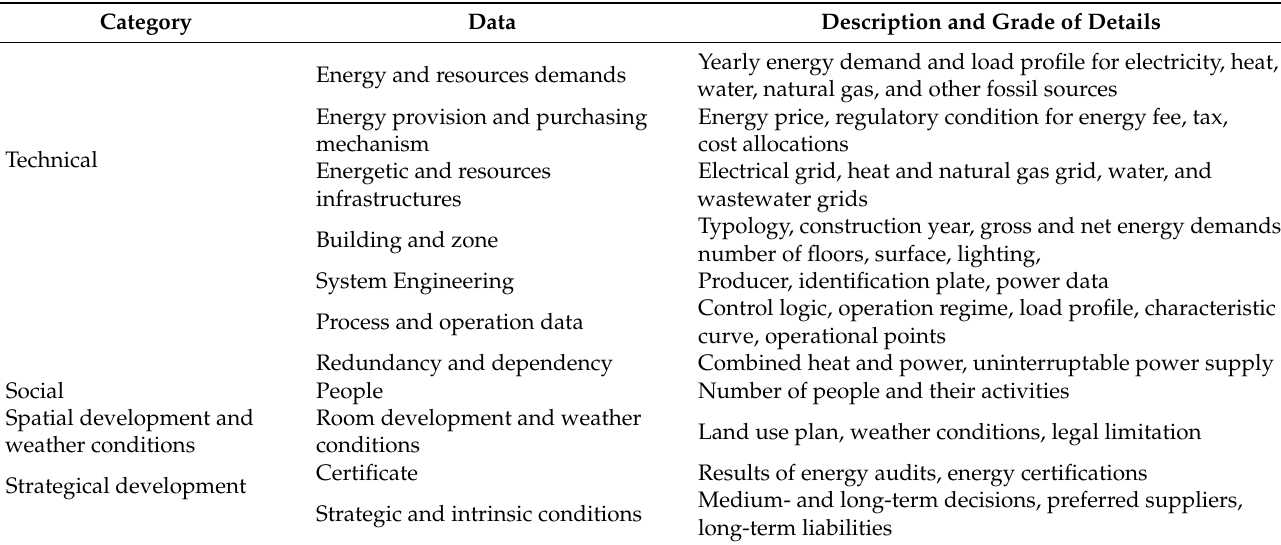
Table 2. Data requirements.